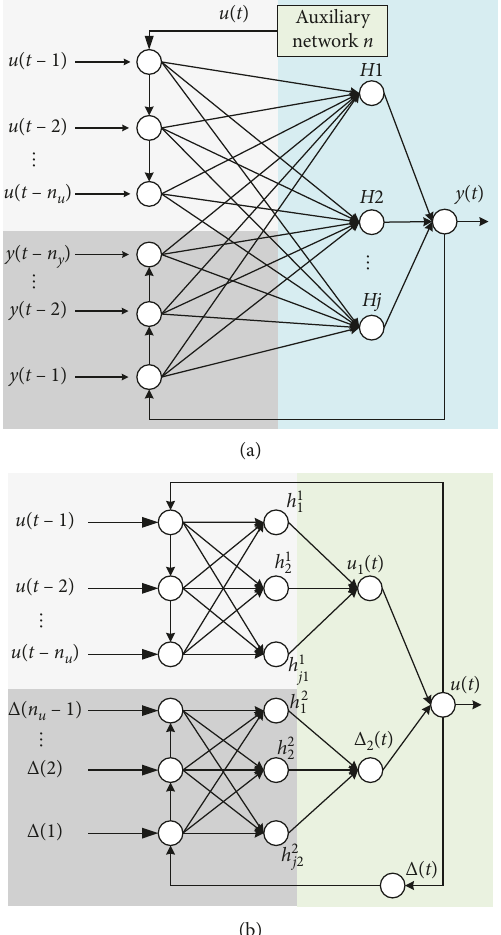
Figure 2: Structure design of the networks: (a) primary network; (b) auxiliary